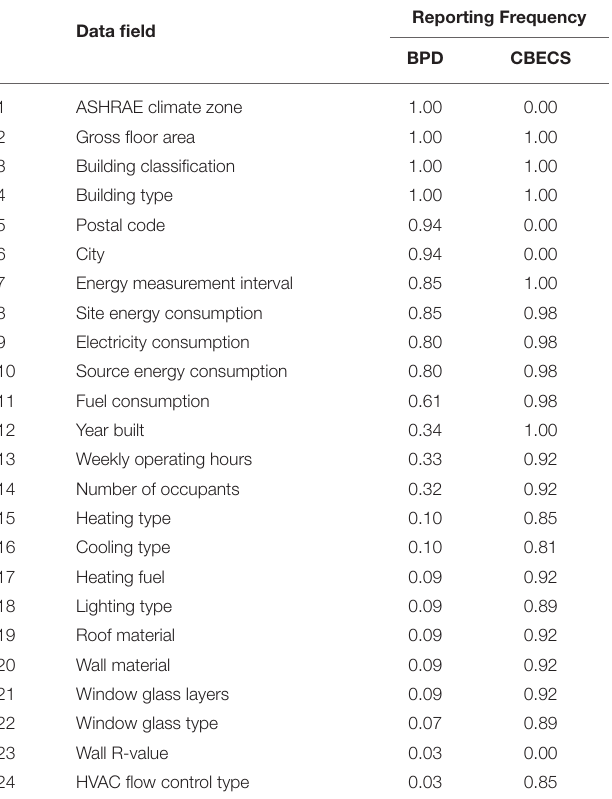
TABLE 1 | Reporting frequencies in BPD and CBECS for the 24 most frequently reported data fields in the Buildings Performance